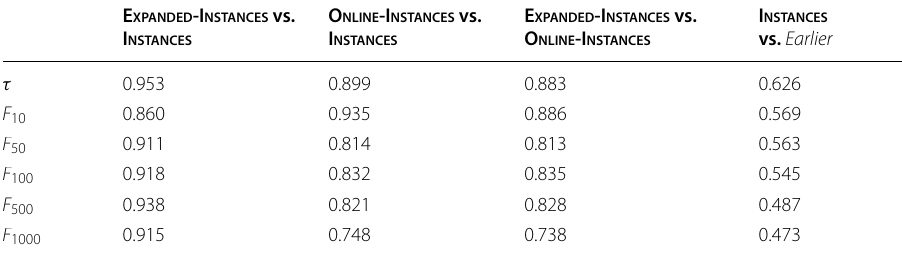
Table 9 Ranking analysis performed via Kendall’s tau ( τ ) and Fagin’s intersection metric ( F ) with various k values (indicated as subscripts) on the PageRank solutions obtained on the Mastodon